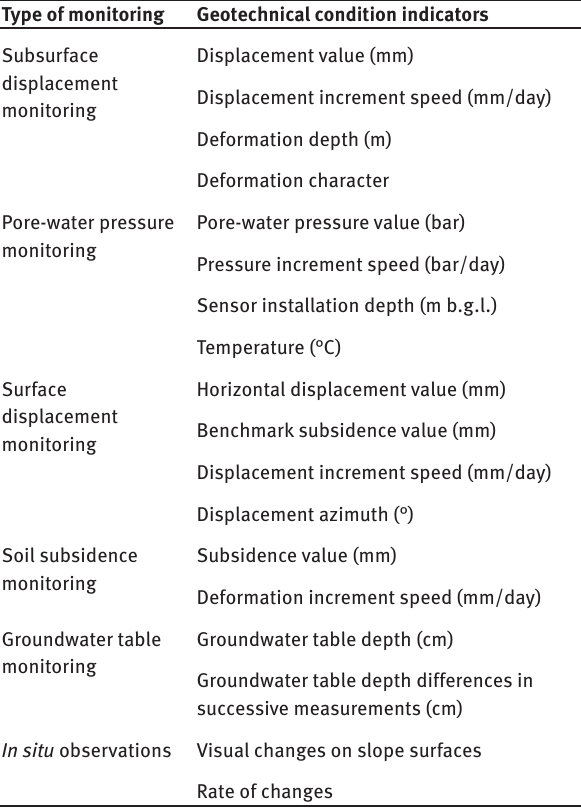
Table 1: Examples of factors indicating the geotechnical